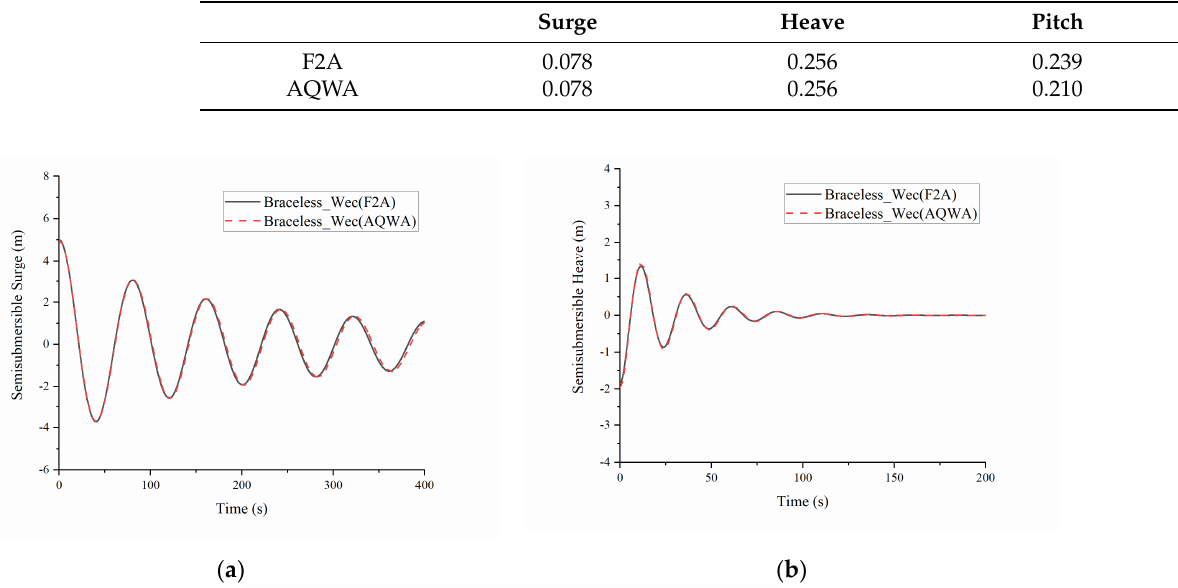
( c ) Figure 4. Time domain curve of free decay test of the semisubmersible platform: ( a ) Surge; ( b ) Heave; ( c ) Pitch. 4.2. Regular Wave Condition In this study, the simulation of typical regular wave conditions (LC1) was performed, and the characteristics of the motion response, mooring response, and produced power of multiple bodies (F2A and AQWA simulation) were compared.